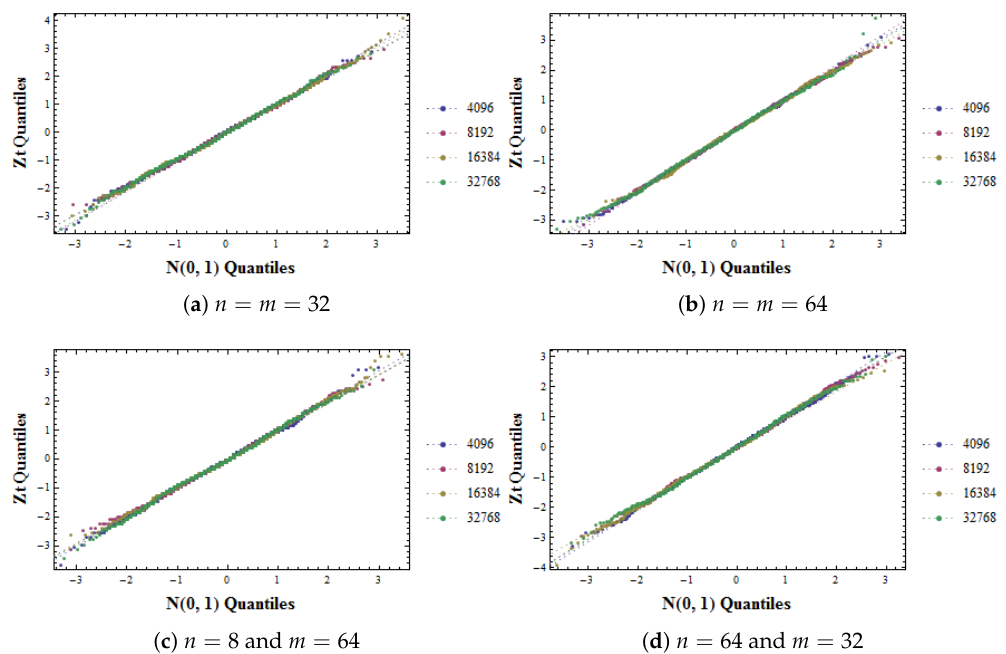
Figure 2. Adjustment of the observed distribution from Z T to N ( 0,1 ) in H i random matrices, which satisfy the BIC.